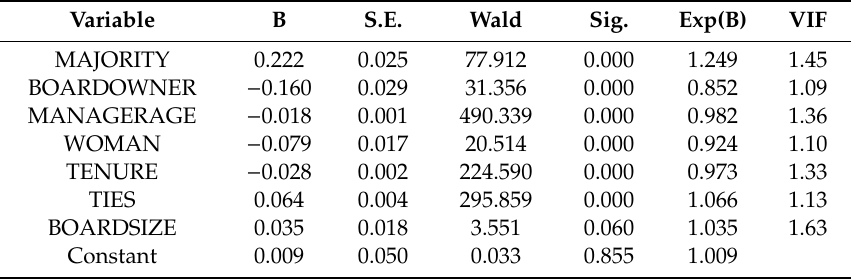
Table 3. Logistic regression model for BINARYDELAY (0—non-violator, 1—violator). Variable B S.E. Wald Sig. Exp(B) VIF MAJORITY 0.222 0.025 77.912 0.000 1.249 BOARDOWNER − 0.160 0.029 − 0.018 TENURE − 0.028 0.002 TIES 0.064 0.004 295.859 BOARDSIZE